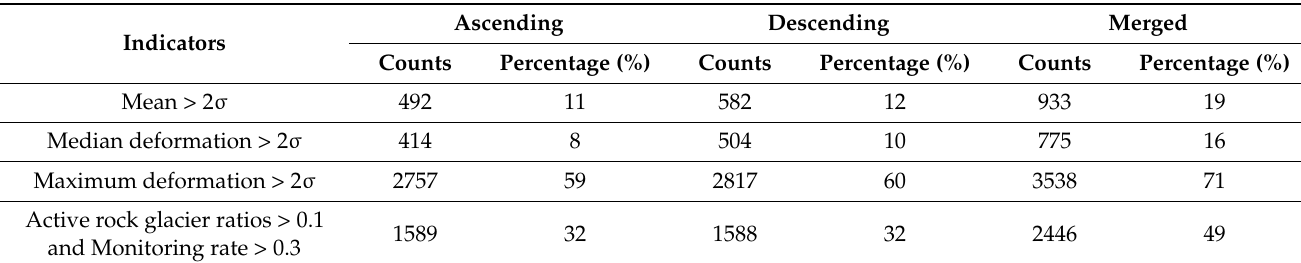
Table 2. Active rock glacier statistics in the central Himalayas.